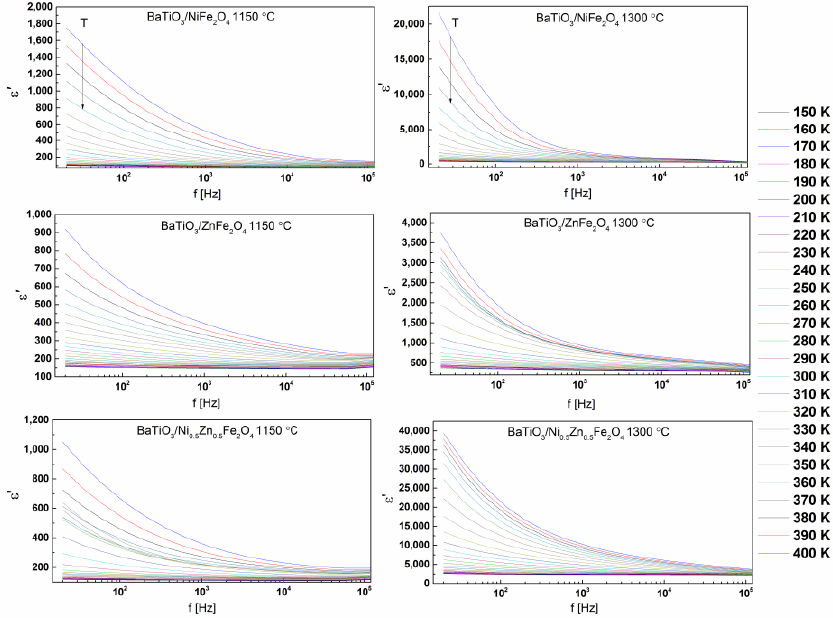
Figure 8. Relative dielectric constant spectra of the sintered samples and their temperature dependence.